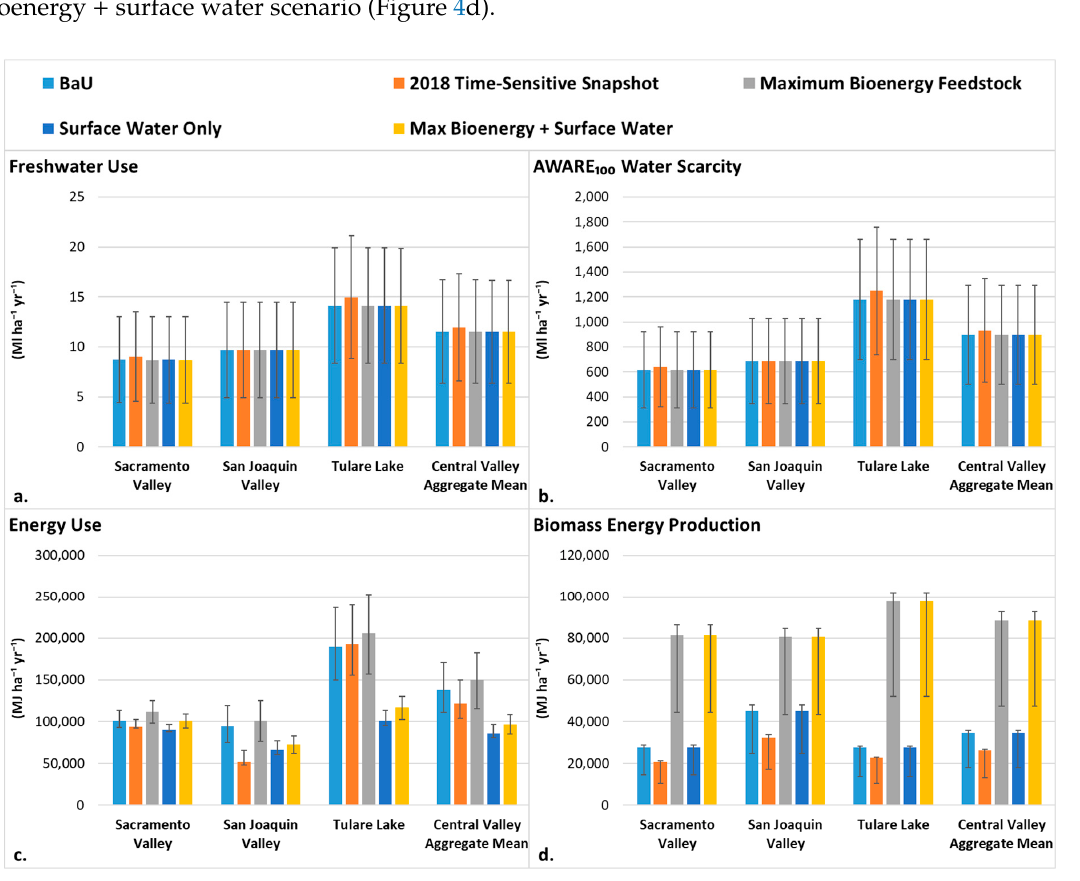
Figure 3. Regional baseline outputs from the SPARCS-LCA model for five almond production scenarios: Business-as-Usual (BaU), which relies on regionally-specific “typical” inputs and practices; a time sensitive “snapshot” accounting for the distribution of various stages of orchard development on a regional basis; maximum utilization of orchard biomass co- and by-products for bioenergy production; use of surface water only for irrigation; and maximum bioenergy and surface water use combined. Model results are presented as ( a ) Freshwater consumption, ( b ) AWARE100 scarcity-weighted water consumption, ( c ) net energy consumption, and ( d ) biomass energy production. Error bars represent the range of output values obtained by varying applied irrigation water, plus or minus 50%. Regional (SV, SJV, and TL) results are aggregated by production area to the CV total, based on 2018 almond orchard distribution among regions: 16.8% total area in SV, 44.7% total area in SJV, and 38.3% total area in TL [1]. Freshwater use and AWARE 100 water scarcity are expressed as mega-liters